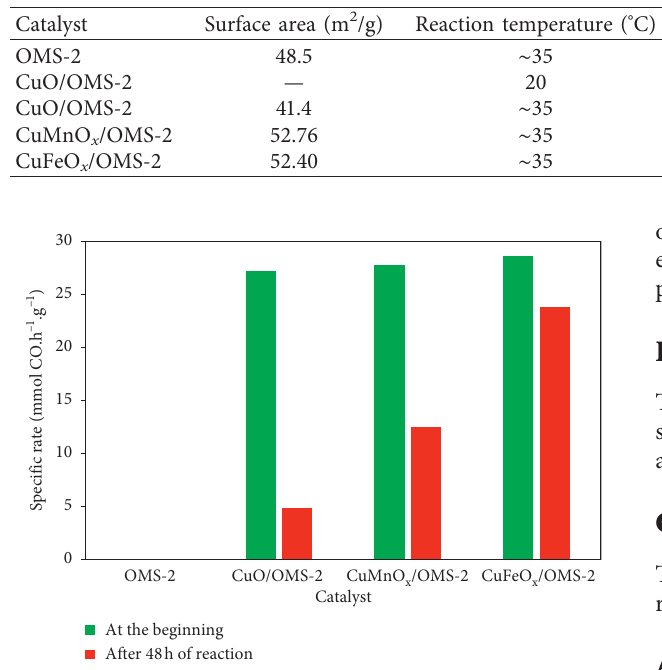
Figure 7: Specific rate of catalysts at room temperature at the beginning and after 48h of CO